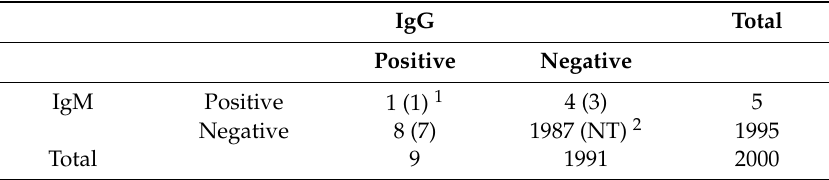
Table 2. Summary of serological tests for anti-TBEV antibodies.